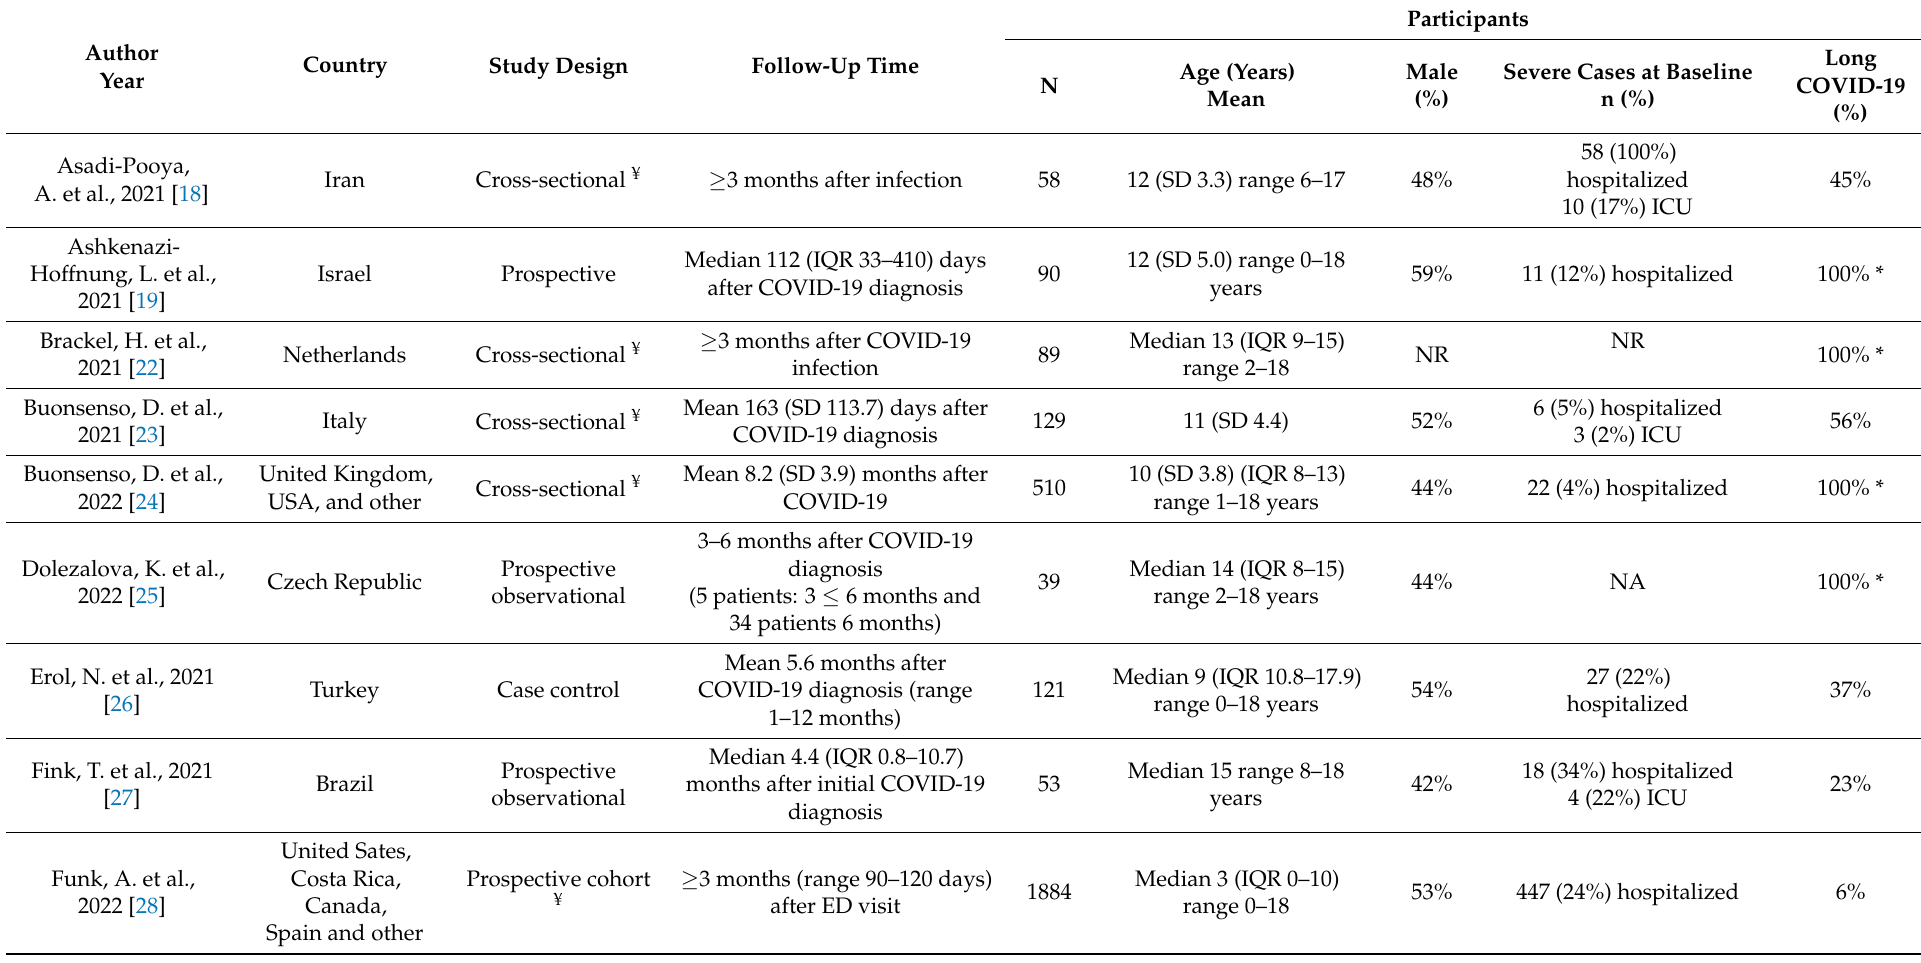
Table 1. Characteristics of the studies included (n =